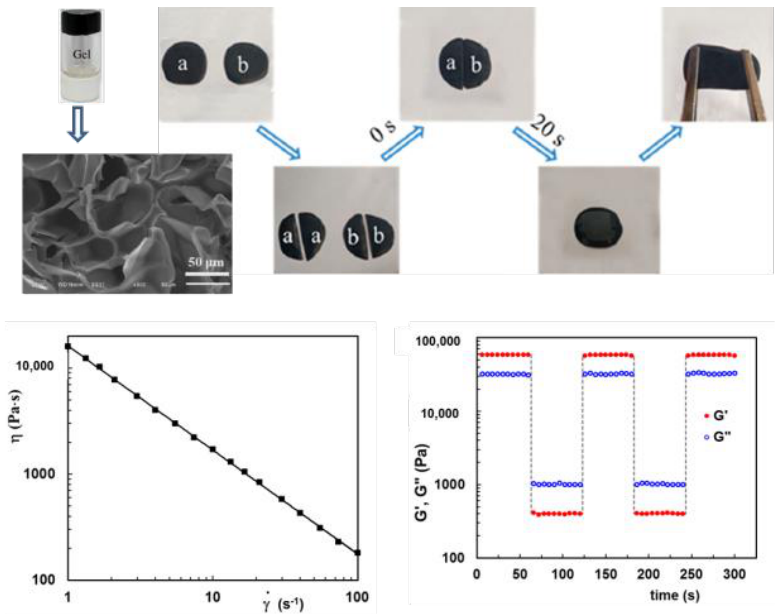
Figure 8. Self-healing and shear-thinning behavior for a 3D printing gel with dynamic covalent bonds and a porous structure. Adapted with permission from ref. [115] copyright 2019 American Chemical Society.